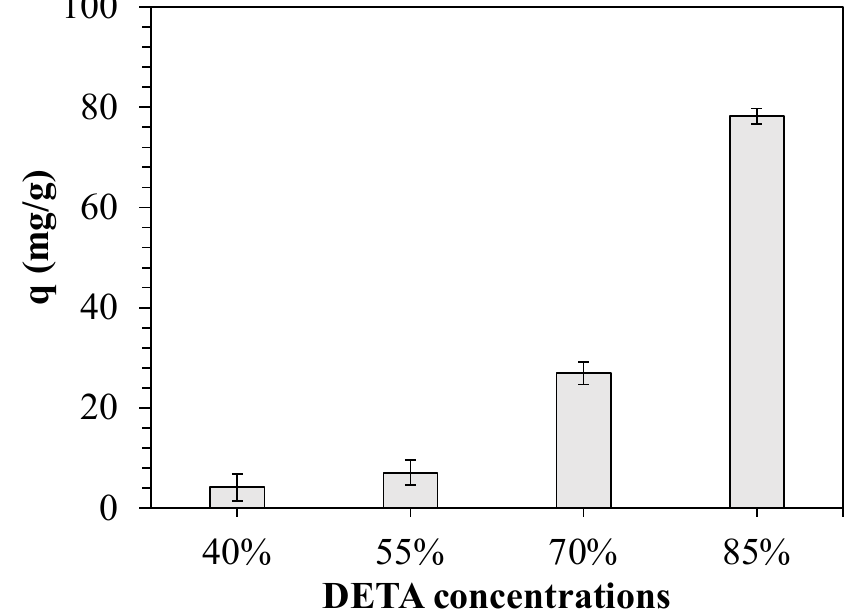
Figure 1. Adsorption capacities (q) of surface-modified polyacrylonitrile fibers with different concentrations of diethylenetriamine (DETA) for Cu(II) removal.